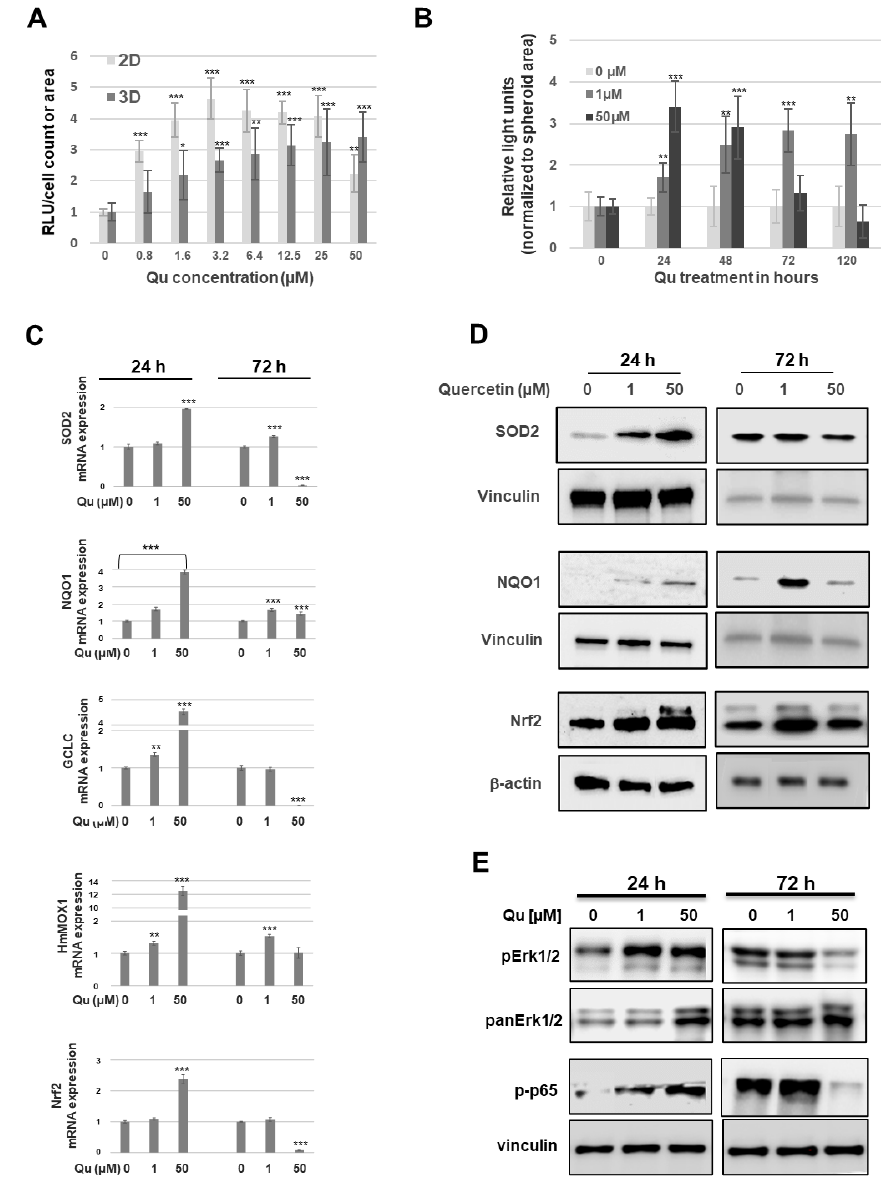
Figure 6. Nrf2 activation in human melanoma cell after quercetin treatment. ( A ) One thousand MCM DLN cells cultured in 2D or 3D spheroids were treated with quercetin (0–50 µ M) and Nrf2 reporter (luciferase) and measured 48 h later. ( B ) Spheroids were treated with 0, 1, or 50 µM of quercetin, and the Nrf2 luciferase activity was measured after 0, 24, 48, 72, and 120 h. ( C ) The expression level of the Nrf2 (NFE2L2) and Nrf2 target genes (SOD2, NQO1, GCLC, and HMOX) in melanoma spheroids were detected by RT-qPCR 24 h and 72 h after quercetin treatment (0, 1, or 50 µ M). The p- values are expressed as * p < 0.05, ** p < 0.01, and *** p < 0.001, compared to the control (0 µ M). ( D ) Western blotting using antibodies against SOD2, NQO1, and Nrf2 or ( E ) pERK1/2 and